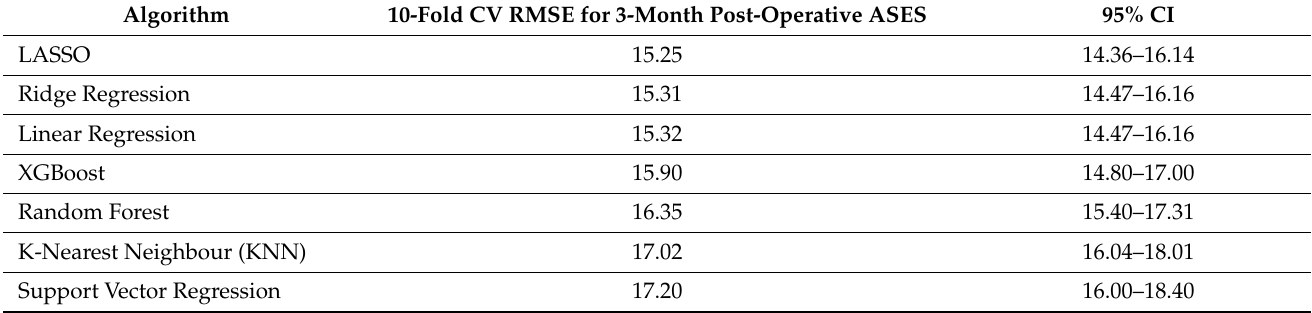
Table 1. Root-mean-square error (RMSE) and 95% confidence interval (CI) calculated using 10-fold cross-validation to help identify “best” machine learning